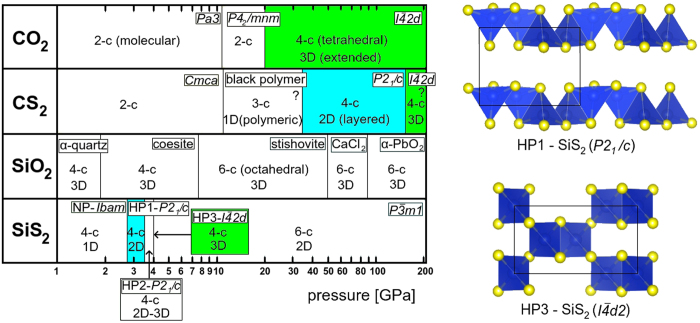
Comparison of zero-temperature structures of CO21234567891011121314, CS228293031, SiO21516171819202122 and SiS 23233343536 showing a rather weak level of similarity. The two structures P21/c and  that are common for some systems are highlighted in the diagram and shown for the case of SiS2. For CO2, phase V is usually created during heating only at pressures over 50 GPa though it is predicted to be thermodynamically stable from 20 GPa101112.